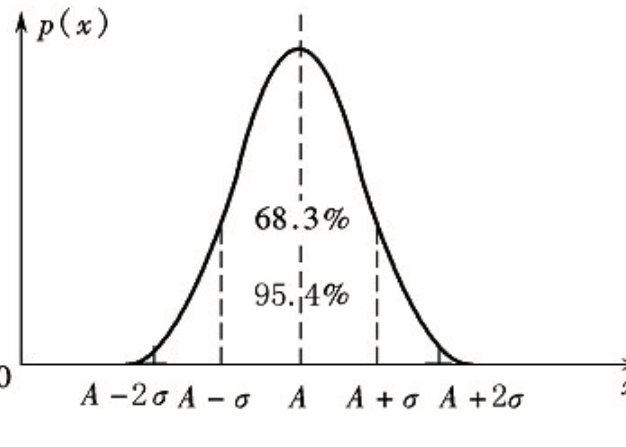
Figure 4. Probability distribution of